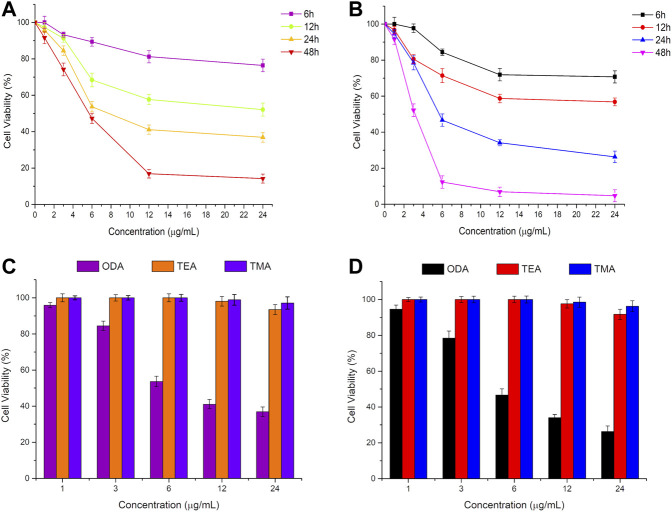

In vitro cytotoxicity profiles of ODA10[(PW11Fe)2] on MCF-7 cells (A) and A549 cells (B) for 6, 12, 24 and 48 h, and different phosphotungstates on MCF-7 cells (C) and A549 cells (D) for 24 h by MTT at different doses. (ODA: ODA10[(PW11Fe)2]; TEA: (TEA)10[(PW11FeO39)2O]·3H2O; TMA: (TMA)10[(PW11FeO39)2O]·4H2O).